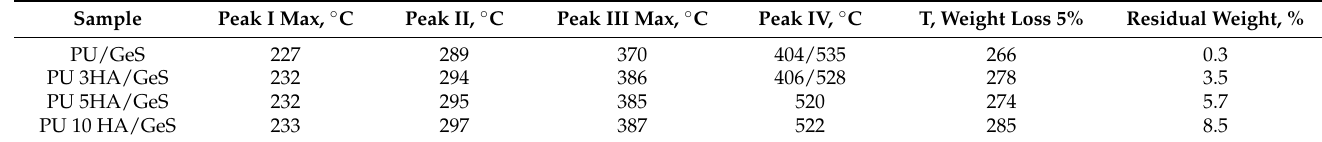
Figure 6. The shape-memory coefficients of ( A ) Rr and ( B ) Rf , calculated based on cyclic-thermome- chanical-tensile test.